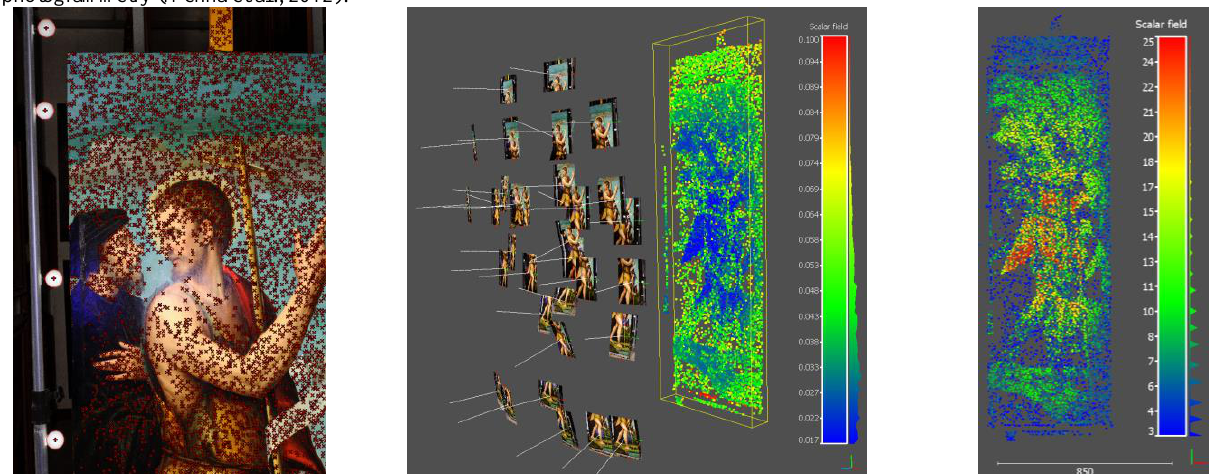
Figure 4. Photogrammetric processing of the Saint John the Baptist images. Left: distribution of the automatically extracted tie points over an image and some of the (ten) spheres used for connecting the back and front of the painting. Middle: camera network geometry and tie points in 3D - colors represent the estimated spatial precision (sigma xyz) of the derived 3D coordinates (units in mm). Right: color-coded visualization of the multiplicity of the derived sparse point cloud, i.e. number of images in which each 3D point is